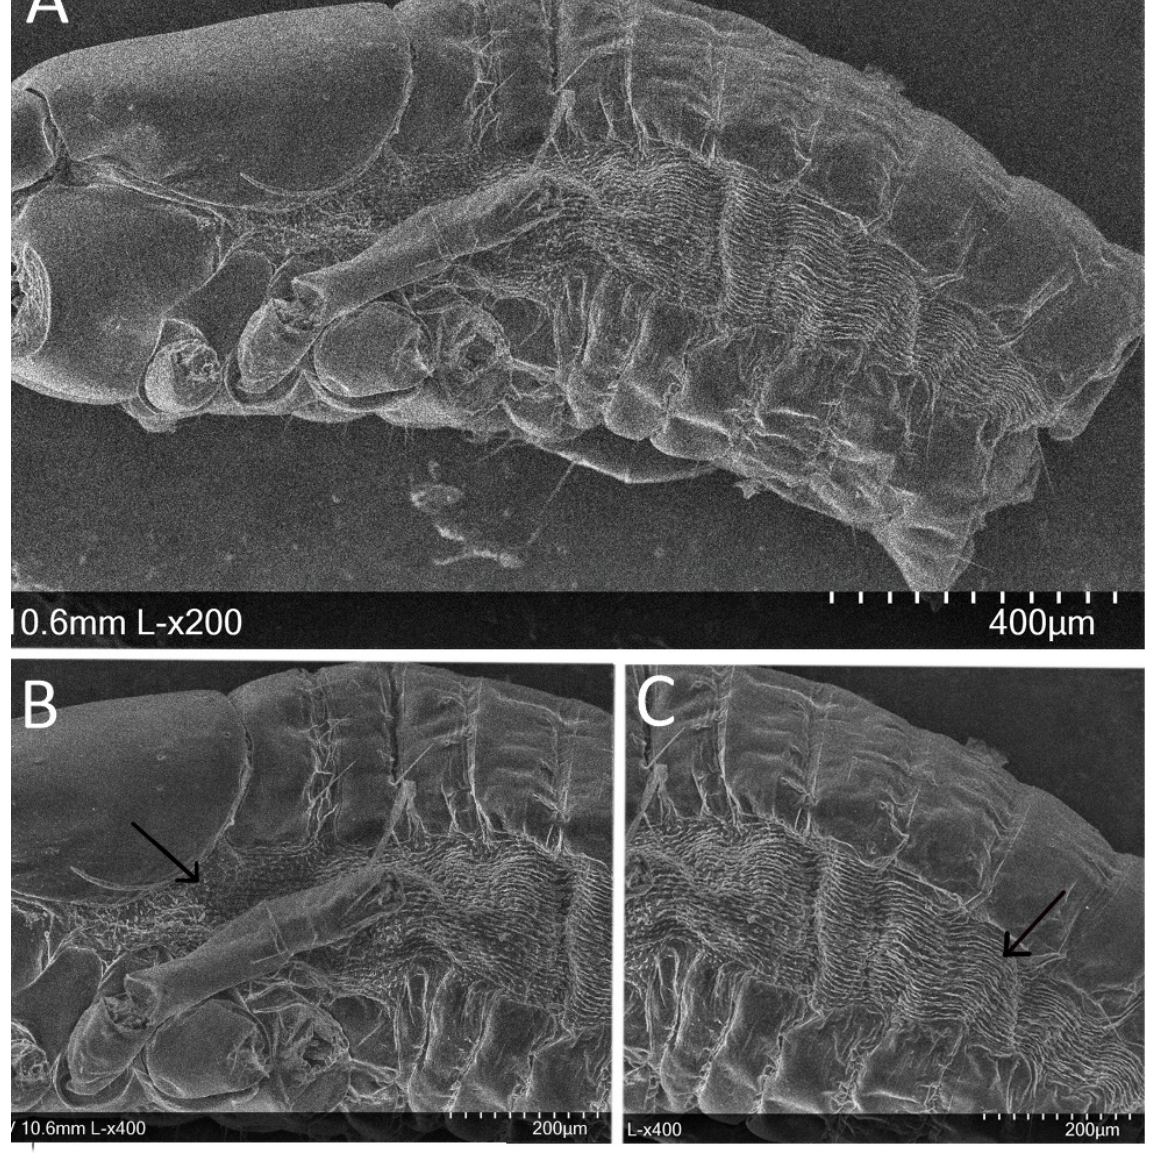
Fig. 6. Scanning electron micrographs of Ideobisium kichwa sp. nov., ♀ , paratype (ZMH A0003686). A . Pleural membrane. B . Close-up of the anterior pleural membrane, showing a granulate structure becoming granulo-striate posteriorly; granulate structure indicated with an arrow. C . Close-up of the posterior pleural membrane, showing a granulo-striate structure